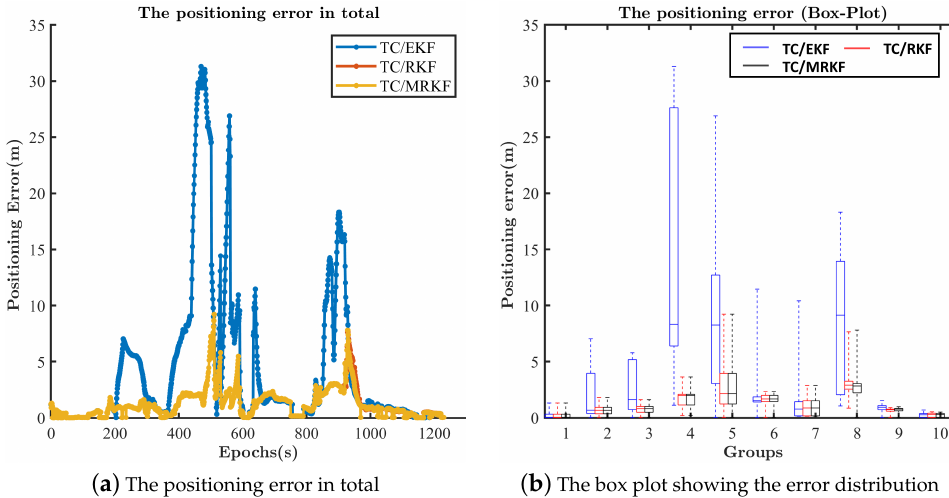
Figure 20. The performances of MRKF for the Odaiba